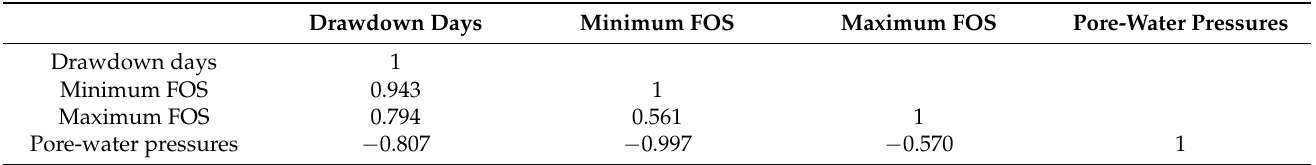
Table 5. Correlation coefficients among different slope stability factors.